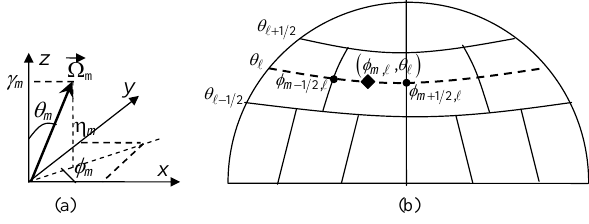
Fig. 4. An angular quadrature: (a) the node, (b) accommodation nodes of the quadrature.